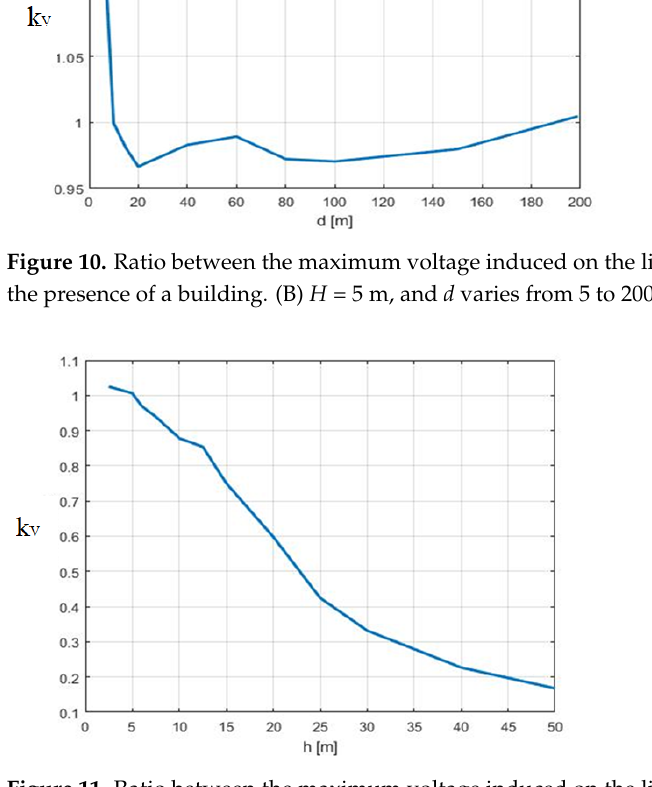
Figure 11. Ratio between the maximum voltage induced on the line considering or not considering the presence of a building. (C) d = 10 m, and H varies from 5 to 50 m.